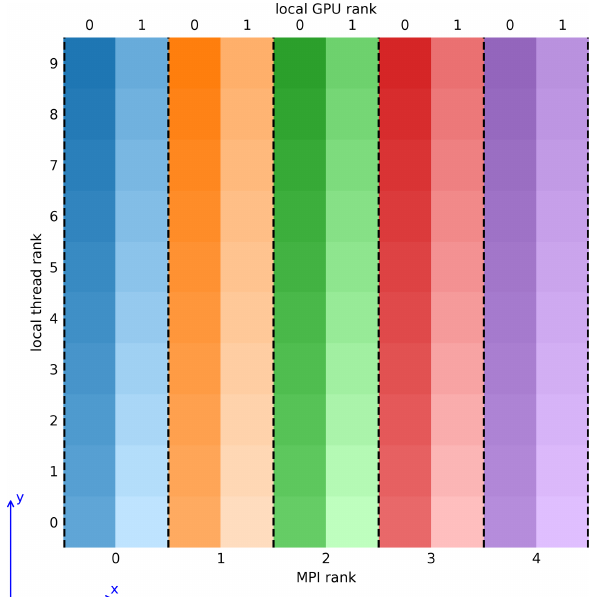
Figure 2. Visualization of the domain decomposition approach of UWLCM. Top–down view on a grid with 10 cells in each horizon- tal direction. Scalar variables are located at cell centers and vec- tor variables are located at cell walls. Computations are divided among five MPI processes, each controlling 2 GPUs and 10 CPU threads. Local thread/GPU rank is the rank within the respective MPI process. Dashed lines represent boundaries over which com- munications need to be done using MPI assuming periodic horizon- tal boundary